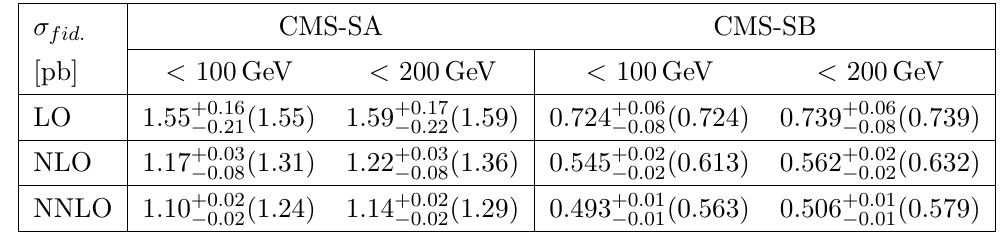
Table 2 . Fiducial cross section at various orders in QCD in the 5FS for LHC 13 TeV. Scale variations are evaluated by taking the envelop of results with 9 scale choices. Numbers in parenthesis correspond to predictions without including QCD corrections in decay of top